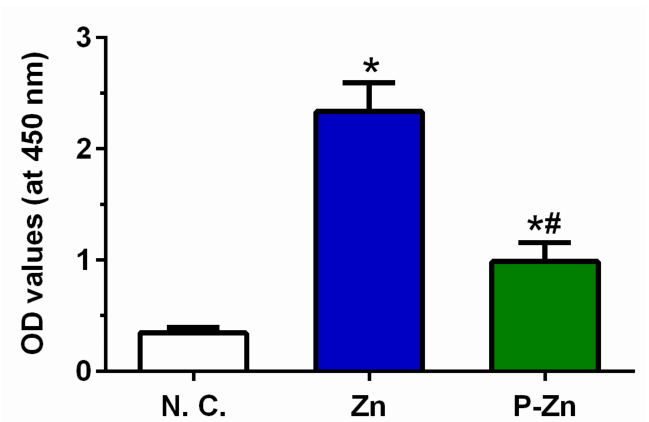
Figure 5. The acellular assay indicates that the OD value is influenced by Zn and pretreated Zn alloys. Fresh medium with 10% CCK-8 reagent was added to samples without cells for 1 h and the values of optical density were read at 450 nm. The chart shows the combined results from three independent experiments with three samples per group in each run. Each bar represents means and standard deviation ( n = 9). * and # represent p < 0.05 when compared to the negative control and pure Zn,